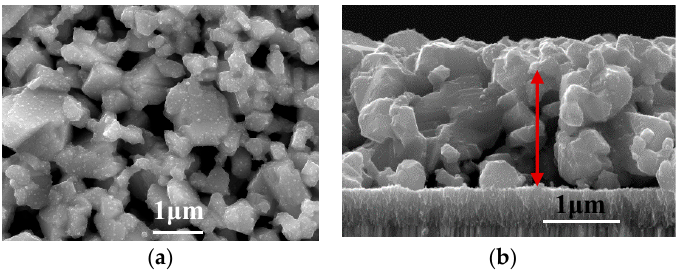
Figure 6. ( a ) Surface and ( b ) cross-section of an annealed CZTS film annealed at 600 °C in a S-rich atmosphere.